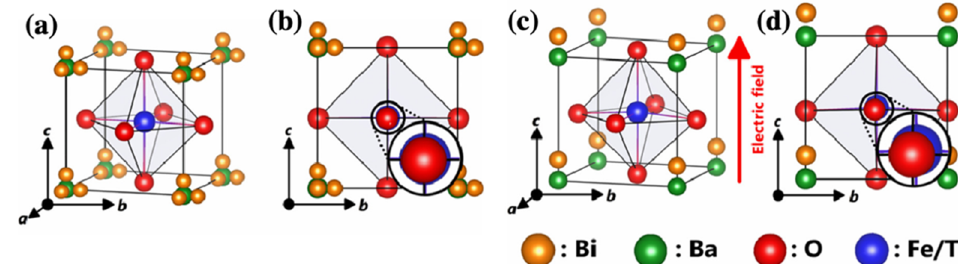
Figure 23. Fluctuated Bi ion’s ordering model under the electric field; ( a ) unit-cell of 0.67BiFeO 3 –0.33BaTiO 3 and ( b ) (100) view of crystal structure without electric field. ( c ) Bi ion’s partial ordering model and ( d ) (100) view of crystal structure under the applied electric field along [001] direction. Reprinted with the permission of [152]. Copyright © 2021 Elsevier.